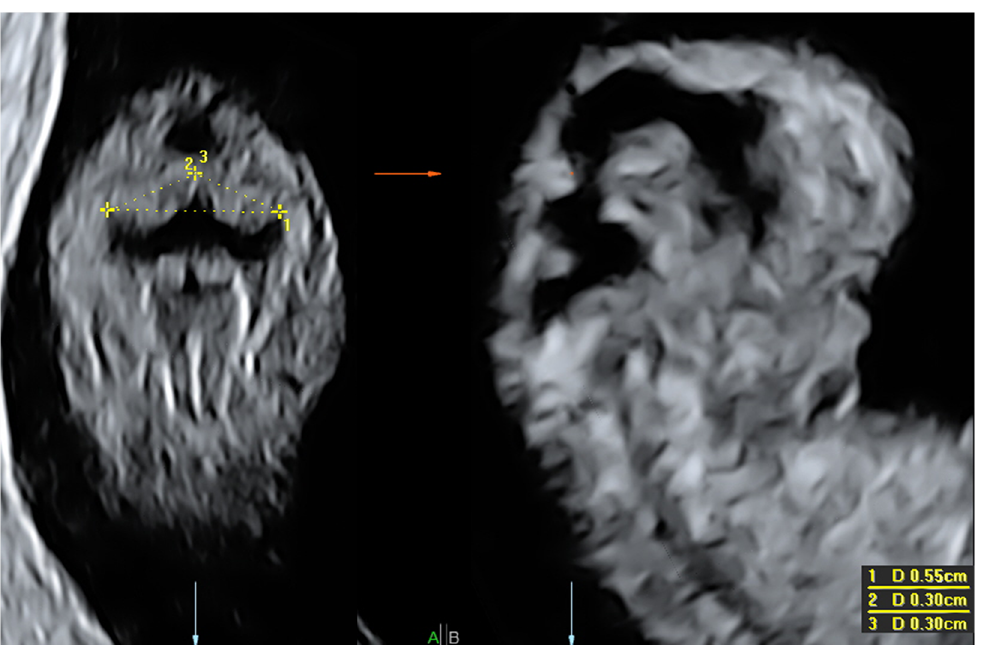
Fig 1. Protocolled display of the three-dimensional ultrasound scan. Three-dimensional ultrasound image of an embryo at 9 +2 weeks GA with the standardized cerebellum measurements TCD (1), LCD (2), RCD (3) in 4D